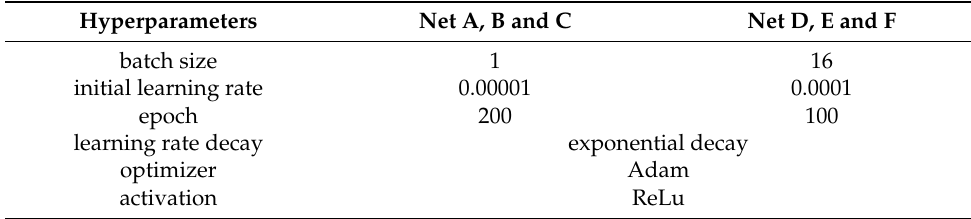
Table 1. CNN hyperparameters.